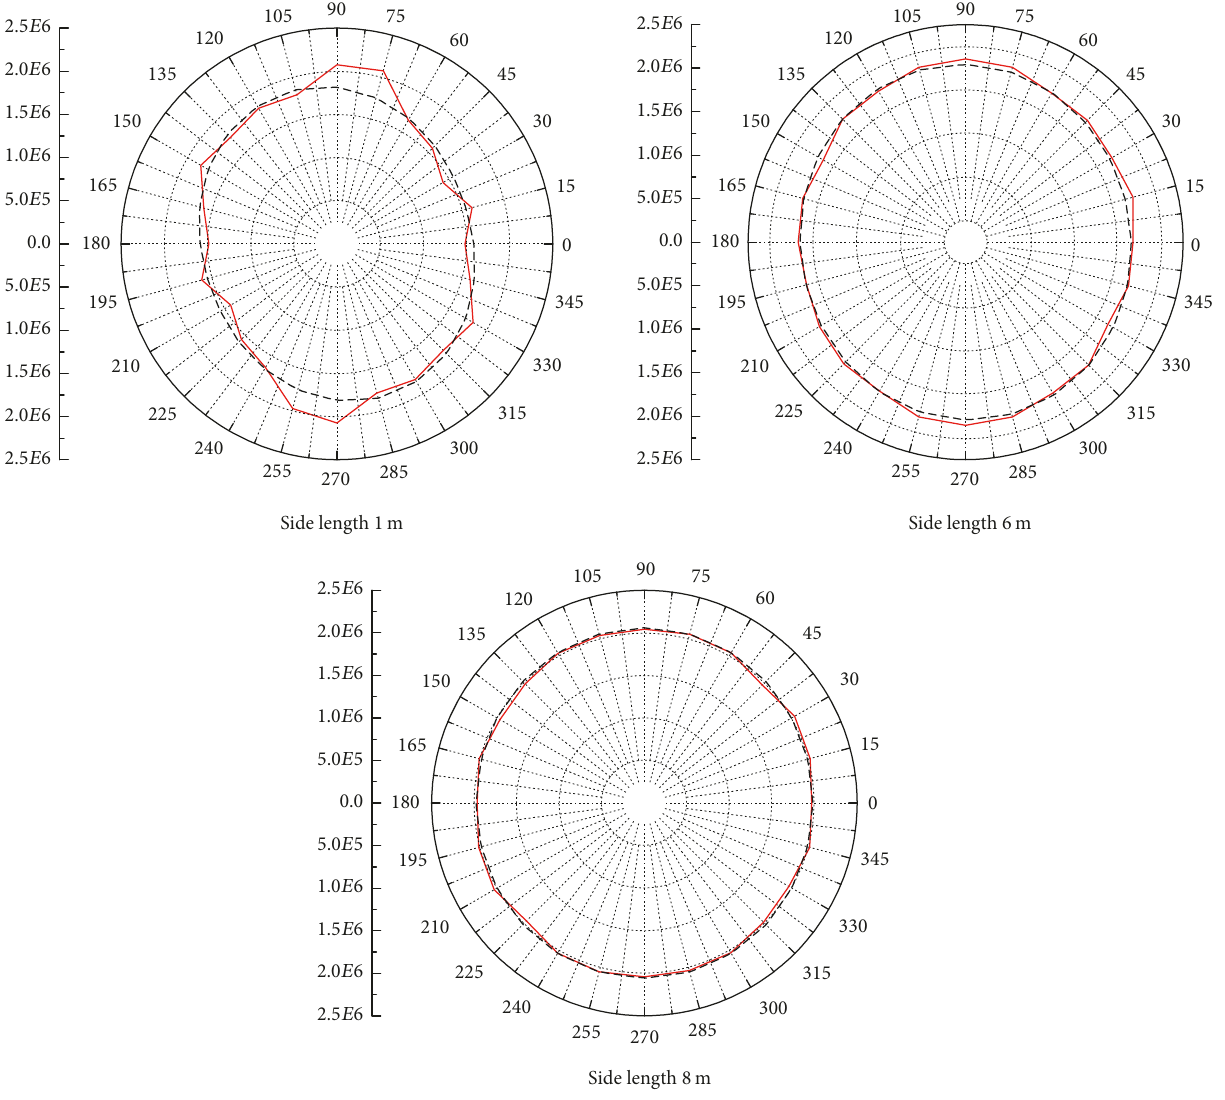
Figure 27: The equivalent intrinsic permeability ellipse with the increasing model size in the Darcy